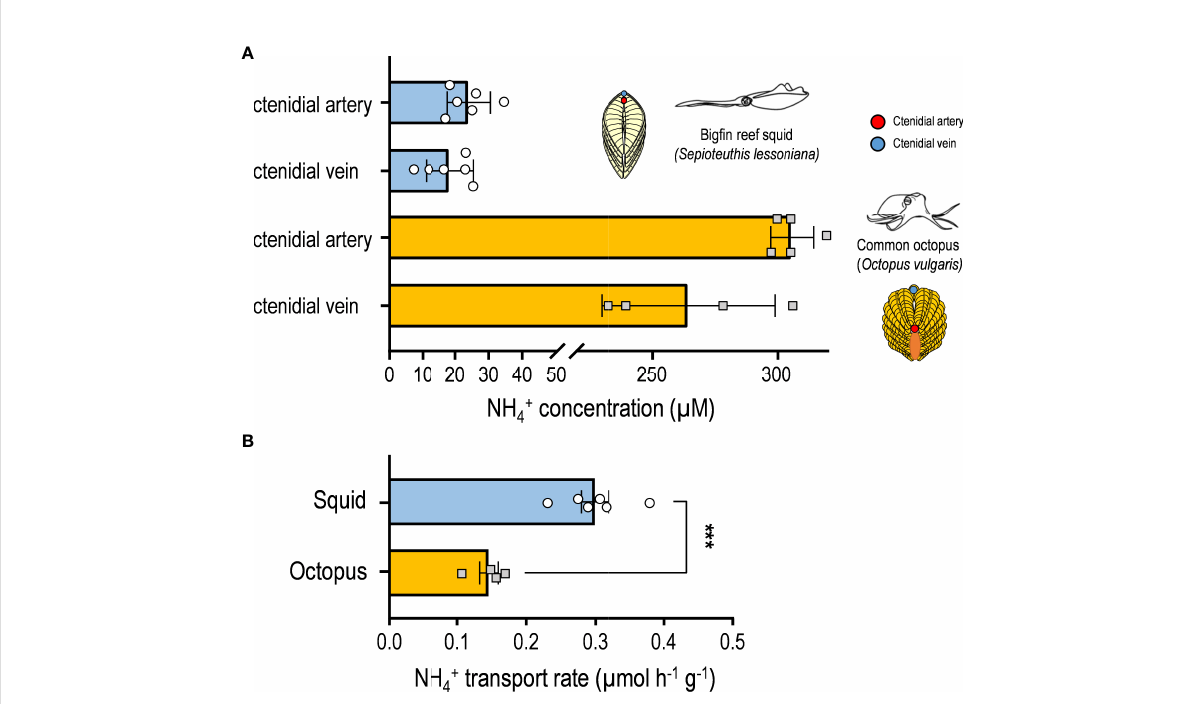
FIGURE 3 NH 4+ concentration and transport rates in cephalopod gills . (A) The NH 4+ concentration in blood collected from the ctenidial artery and ctenidial vein of squid and octopus. (B) The NH 4+ transport rates were determined using the fl uid collected from the perfusate in perfused gills. The estimated values are presented as mean ± SD (n = 4~6). Asterisks indicate signi fi cance levels of p < 0.001